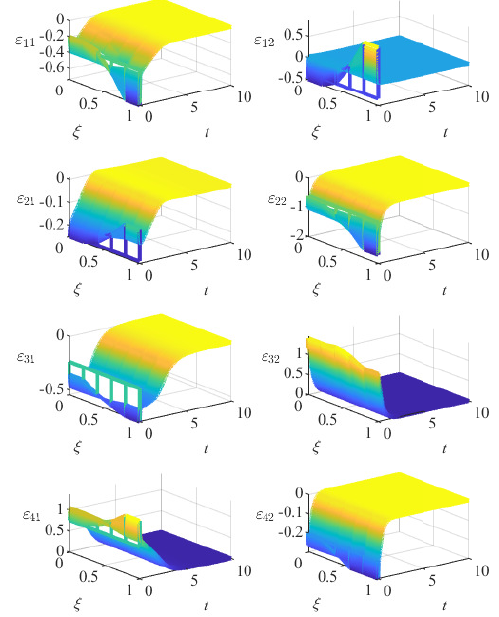
Figure 1. The system error ζ i ( η , t ) of MAS with boundary coupling (4) in Example 1.